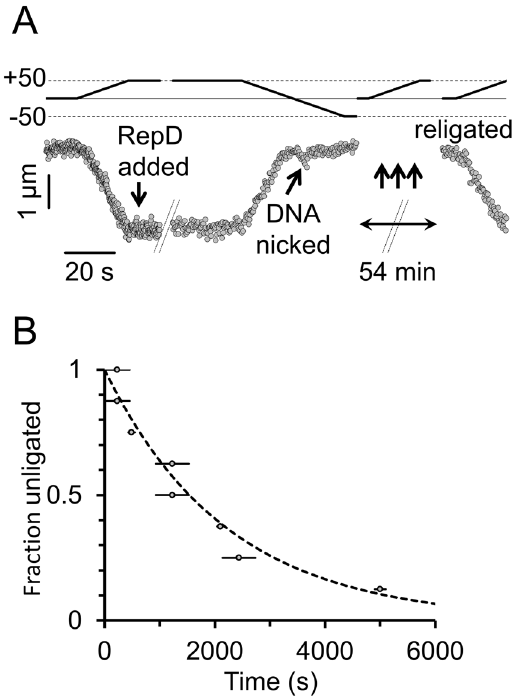
Figure 3. DNA nick-religation activity by RepD. ( A ) Upper trace (solid line) shows rotational position of the magnetic tweezers and the lower trace (filled circles) shows the bead height as a function of time. The 10-kb dsDNA was first positively supercoiled (by + 50 turns) and then RepD (100 nM) was added (down-arrow). The magnetic field was then rotated (by − 100 turns) driving the bead and associated DNA molecule toward 50 turns of negative supercoiling. In this example, the DNA molecule was nicked (diagonal arrow) almost as soon as it started to enter the regime of negative supercoiling. Because the DNA had been nicked it could no longer undergo the characteristic length changes associated with supercoiling. Repeated cycles of 50 positive turns of field rotation were then applied to test if the DNA molecule was “supercoilable”. Here, after 54 minutes, the DNA spontaneously religated, and could again be supercoiled. ( B ) Cumulative frequency plot showing the number of nicked DNA molecules remaining as a function of time (n = 8). The mean time for religation to occur was 1,420 seconds (~24 minutes), giving a rate constant (dotted line) of 5 × 10 − 4 s − 1 . The horizontal lines indicate timing uncertainty due to gaps between applications of the + 50 turn test protocol (see (A) above). Experiments were at F = 0.4 pN and 23